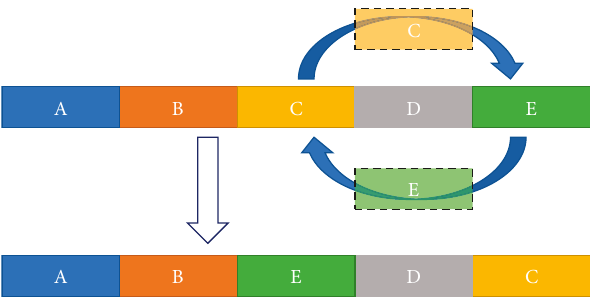
Figure 7: Mutation in GA.